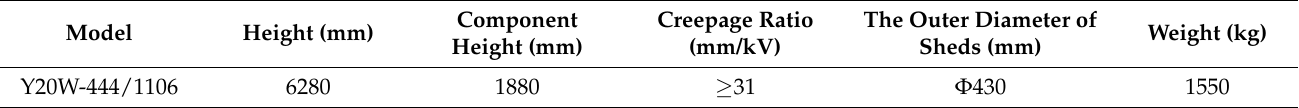
Table 1. External dimensions of 500 kV arrester.